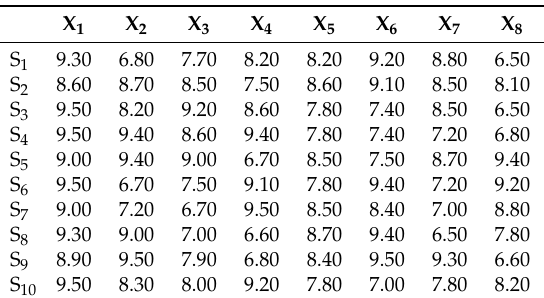
Table 4. Supplier’s Rating